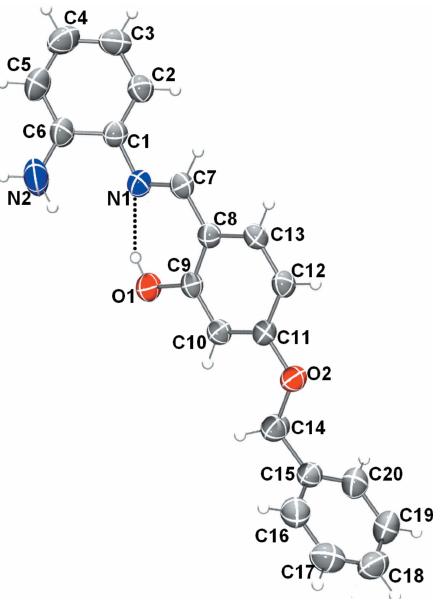
Figure 1 The molecular structure of compound (I), with the atom labelling. Displacement ellipsoids are drawn at the 50% probability level. The intramolecular O—H (cid:3)(cid:3)(cid:3) N hydrogen bond is shown as a dashed line.